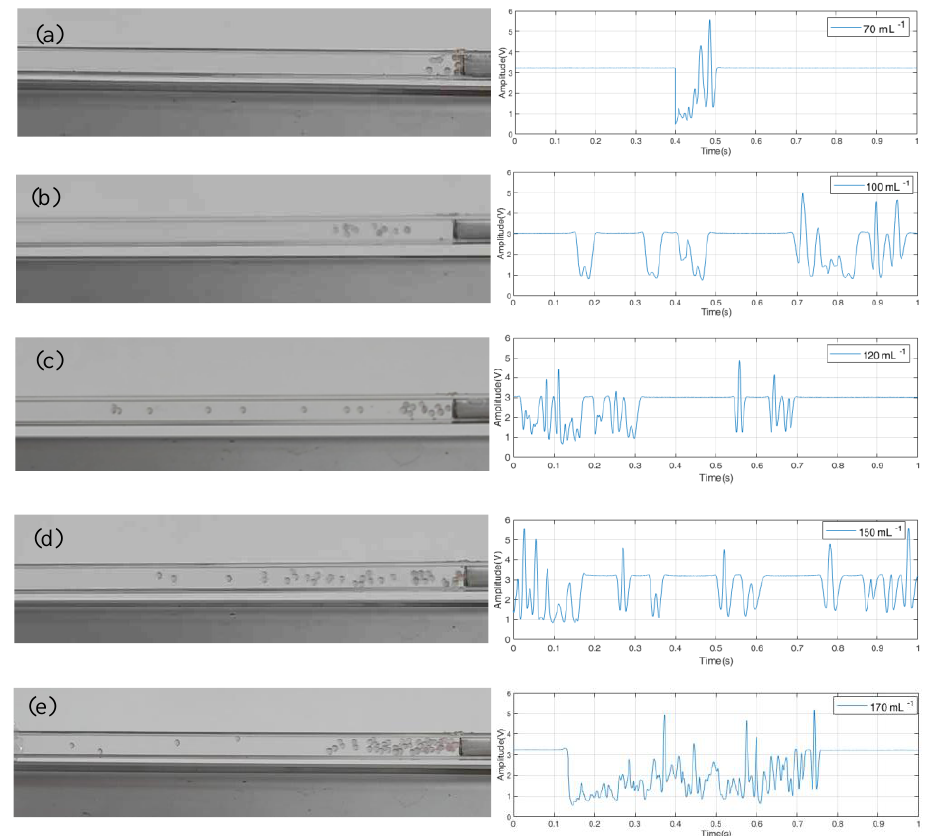
Figure 3. Optical signals of two − phase flow with different concentrations: ( a ) 70/mL; ( b ) 100/mL; ( c ) 120/mL; ( d ) 150/mL; ( e ) 170/mL.